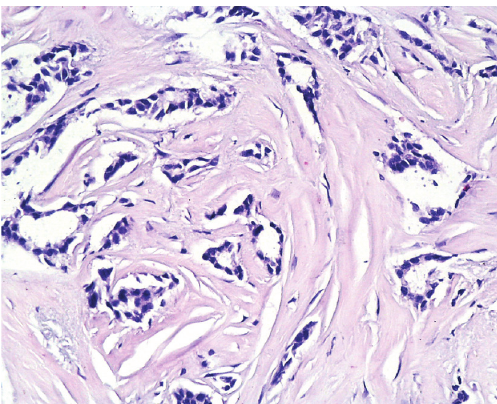
Figure 7: Negative control. This was obtained by omitting the primary antibody. The sample is from invasive ductal carcinoma, GII. Sample is counterstained with HE. Magnification 200x.